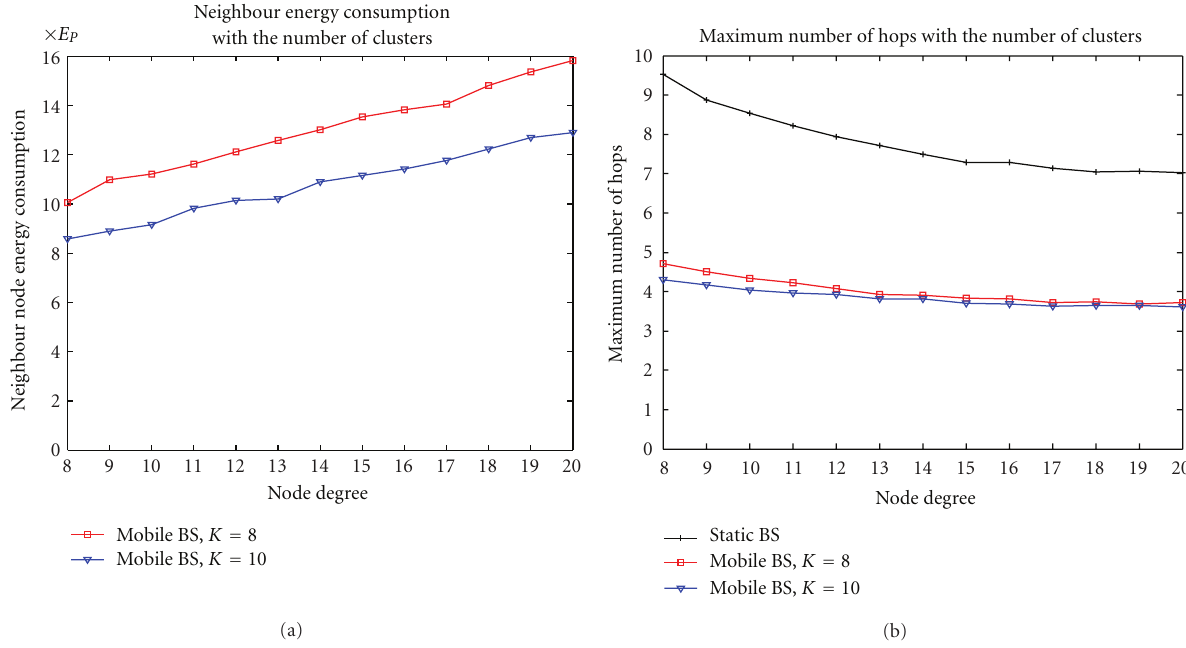
Figure 9: (a) The energy consumption for neighbouring sensor nodes of a cluster head as the node degree is varied, for various numbers of clusters. (b) The maximum number of hops as it varies with the node degree, for static and mobile BSs.